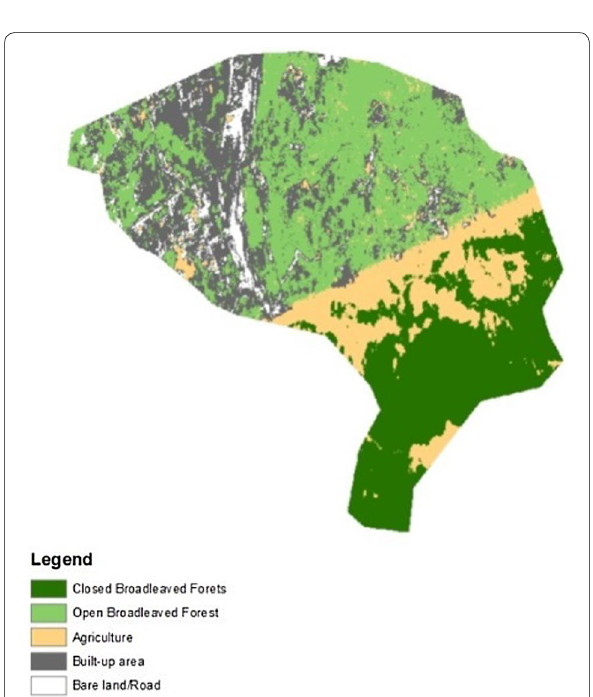
Fig. 11 Land cover classification for Guhe Khola (2015)